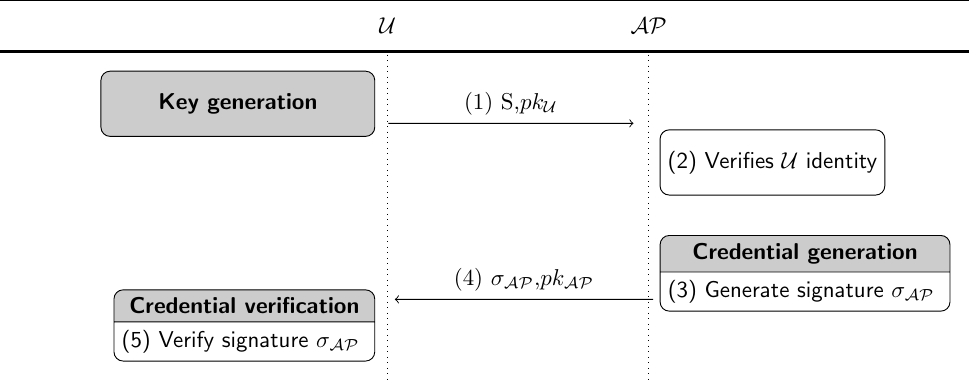
and during the credential issuance U AP